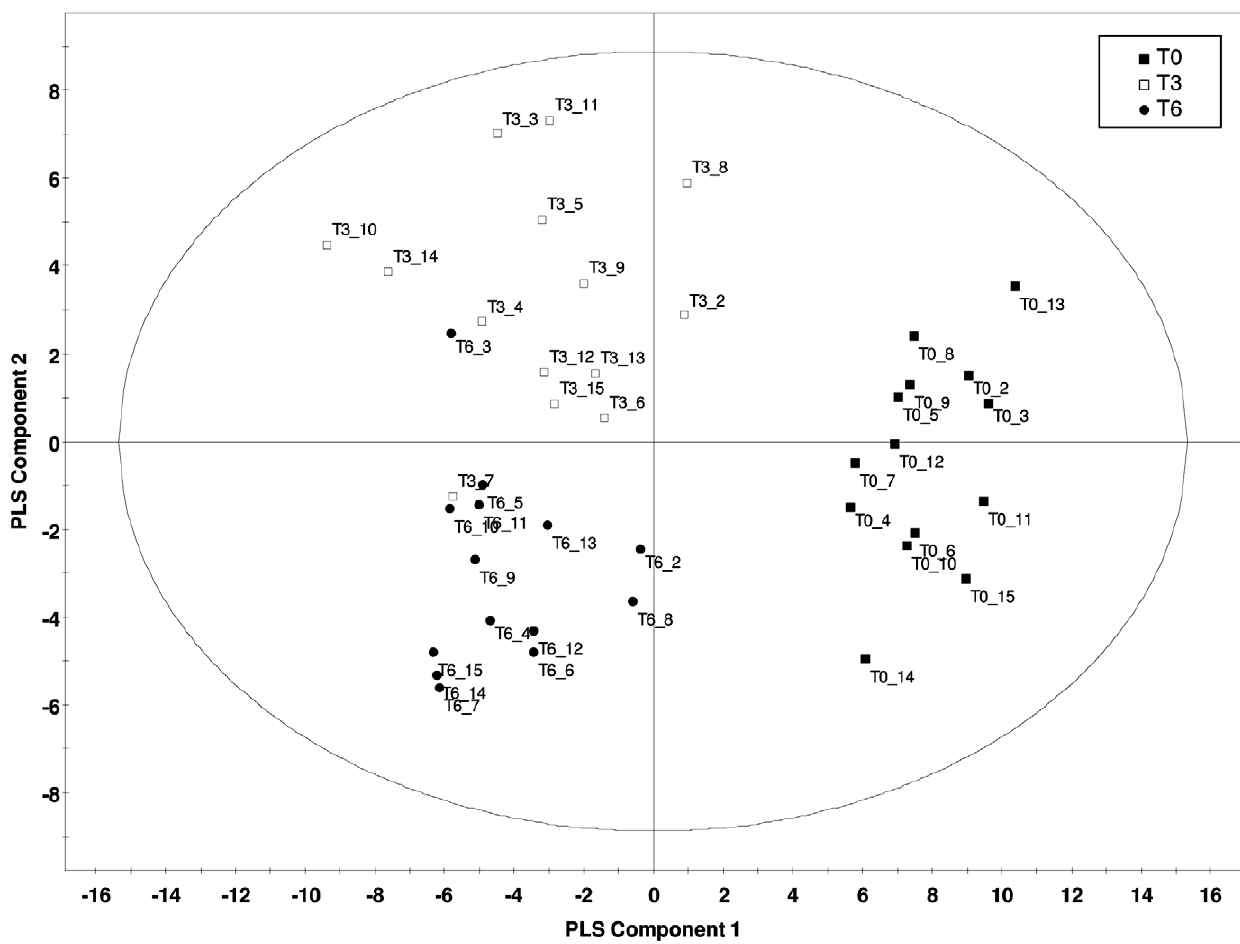
Figure 3. Partial least squares discriminant analysis of 172 known metabolites in 14 subjects distinguishing the three classes: pre- operative (T0) vs. 3 months after RYGB (T3) vs. 6 months after RYGB (T6). The first component distinctly classifies T0 vs. after RYGB (Q2=0.423), the second component further distinguishes T3 and T6 (Q2(cum)=0.640 for two-component PLS-DA model). Model performance was quantified by Q2 values from leave-one-subject-out cross validation. Q2 depicts the fraction of the total variation that is predicted by each PLS component, while Q2(cum) depicts the cumulated fraction of the total variation predicted by the model.